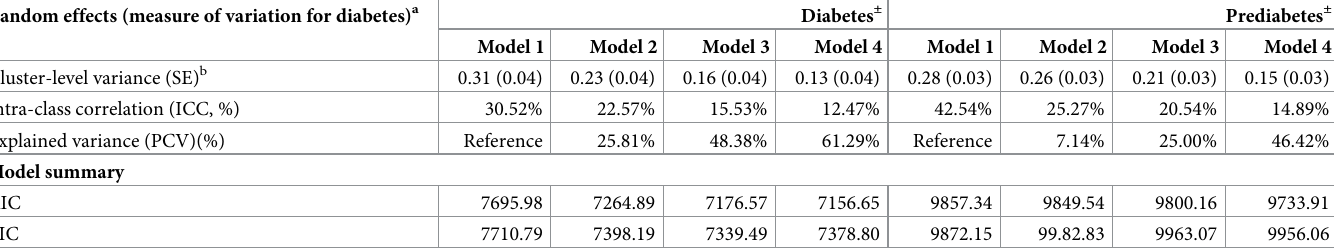
Table 3. Results from the random intercept model (measure of variation) at cluster/community level for diabetes and prediabetes in adults aged � 18 years in Ban- gladeshi population, BDHS 2017–18. Random effects (measure of variation for diabetes)